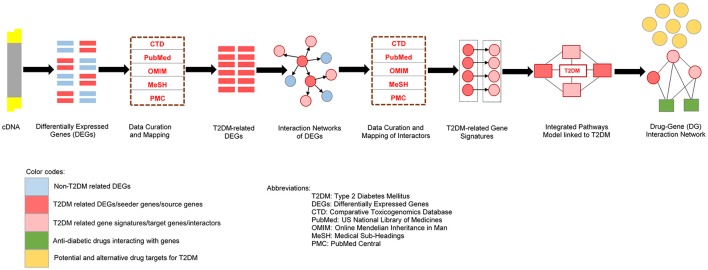
The comprehensive and squential steps in our study design.